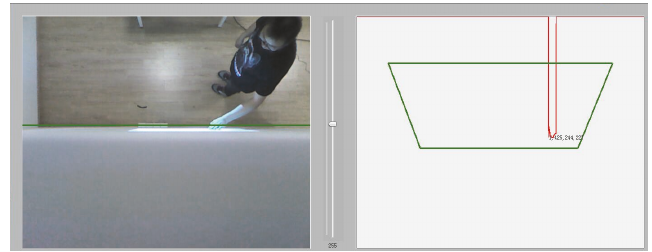
Figure 4: Gesture tracking and positioning effect with the federated tracking filter algorithm.